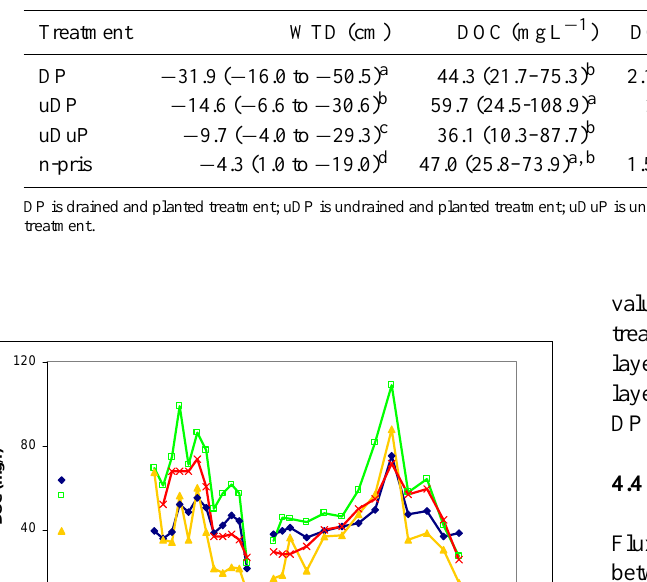
Table 1. Water table depth (WTD) from the soil surface and water chemistry mean values (and ranges) measured across the treatments at Flanders Moss over the duration of the experiment in 2008 and 2009. Different letters within each variable indicate significant differences ( p < 0.05).